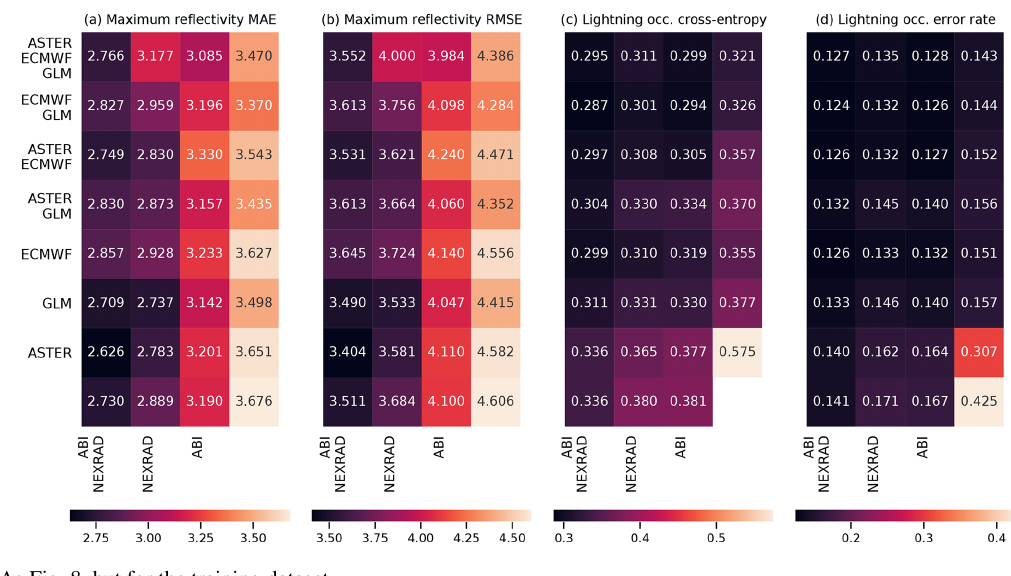
Figure A1. As Fig. 8, but for the training dataset.